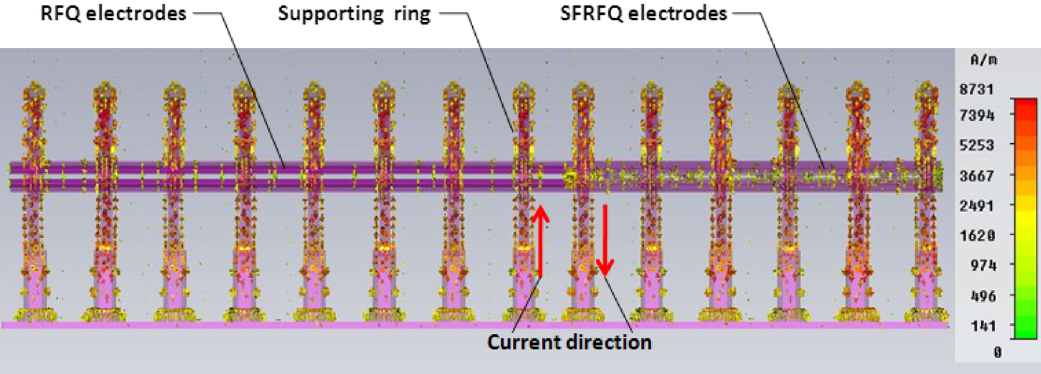
FIG. 7. Surface current distribution of the coupled cavity.